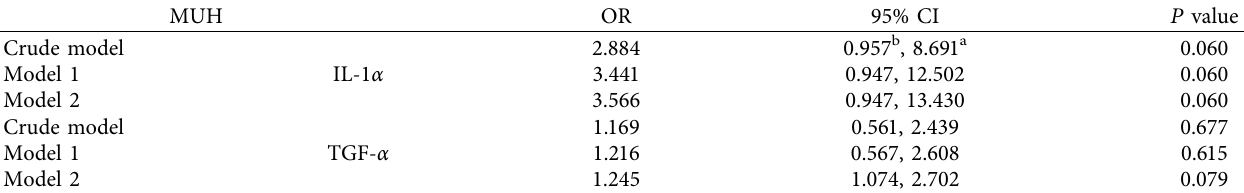
Table 3: Association of TGF- α , IL-1 α , metabolically healthy, and metabolically unhealthy obesity among overweight and obese women ( N � 228).